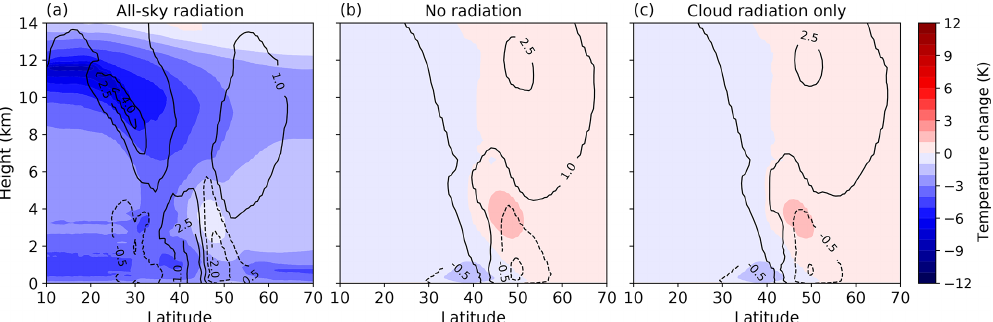
Figure 2. Zonal-mean changes in temperature and zonal wind (black contours, ms − 1 ) at day 3 for simulations with (a) all-sky radiation, (b) no radiation and (c) cloud radiation only.